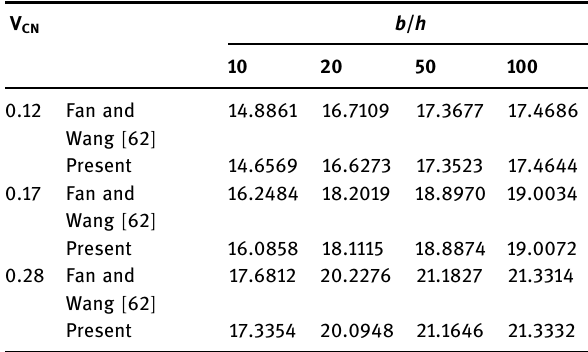
Table 6: Comparison of the fundamental frequencies for [ θ C /90 F ] 2 plates